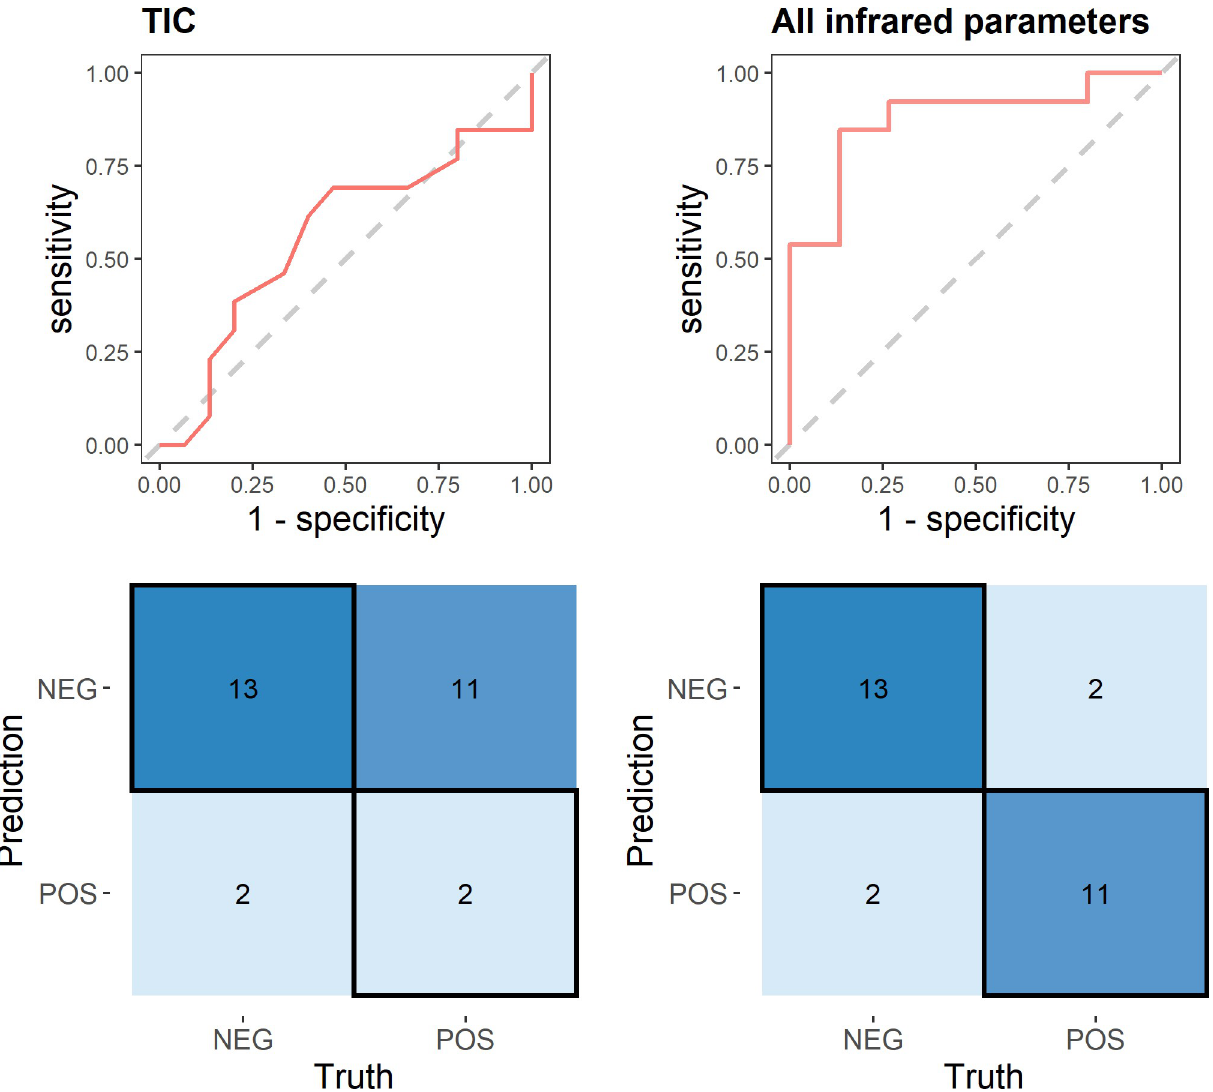
Fig 5. ROC curves and confusion matrix of predictive models for COVID-19. (a) Logistic regression with max temperature of eye inner canthus (TIC) as the only predictor and (b) Random Forest model (mtry = 4, min_n = 3, trees = 1000), combining all thermal parameters as predictors. RF model showed vastly improved performance, evidencing that considering one single temperature spot (common practice in the infrared solutions currently) is problematic for COVID-19 detection.